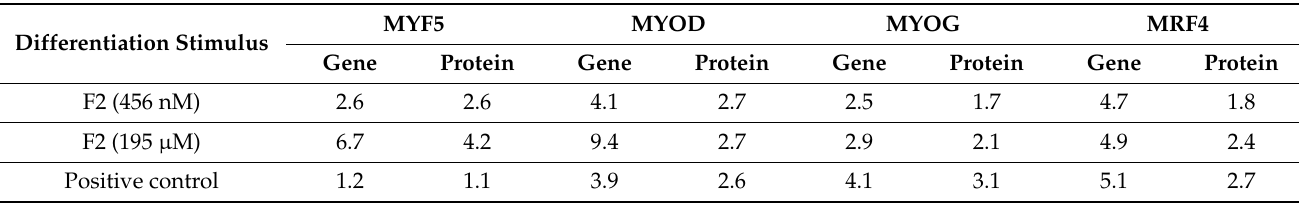
Table A1. The expression of genes and proteins of myogenic differentiation induced by F2 fullerene or the standard differentiation kit (a positive control) after 14 days of incubation; the gene RNA amount and protein amount were the mean values for three experiments related to the blank. In the blank experiments, cells were incubated without F2 or the differentiation